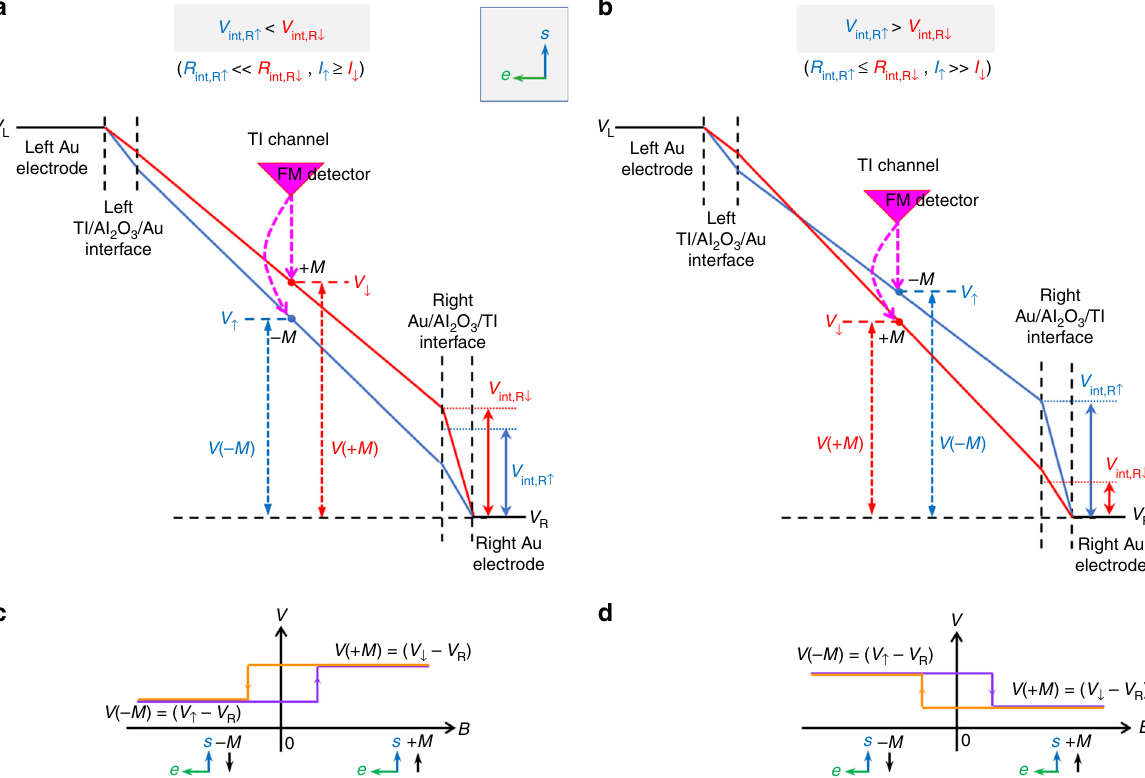
Fig. 2 Voltage pro fi le and predicted lineshape of measured spin voltages. Voltage pro fi les for the spin-up (blue) and spin-down (red) electrons for a left fl owing current, for the case ( a ) V Predicted lineshape for the spin voltage measured by a ferromagnet/tunnel barrier detector contact for the voltage pro fi les in ( a , b ) are shown in ( c , d ),